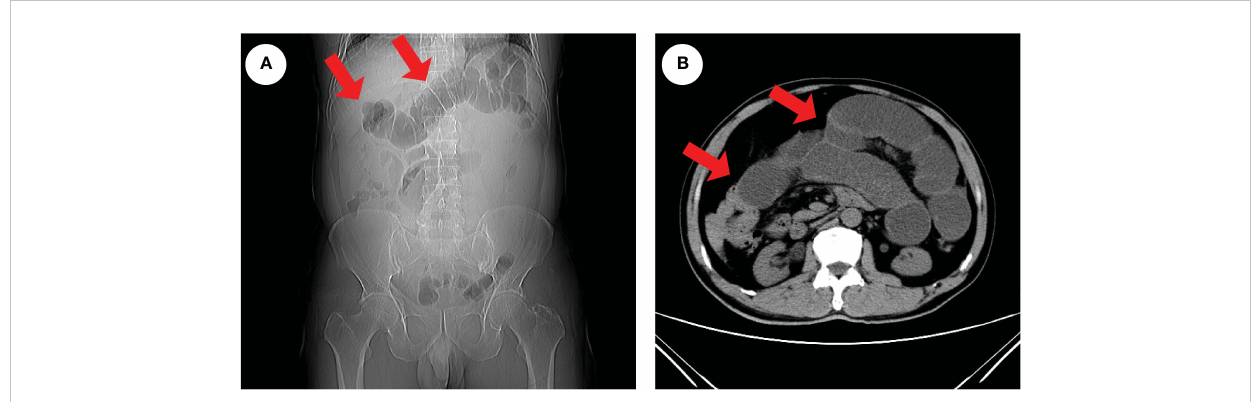
FIGURE 1 Radiologic fi ndings of intestinal obstruction. An abdominal CT examination in an emergency was performed on the patient and revealed extensive dilatation of the transverse colon (red arrows), indicating proximal intestinal obstruction (A, B)